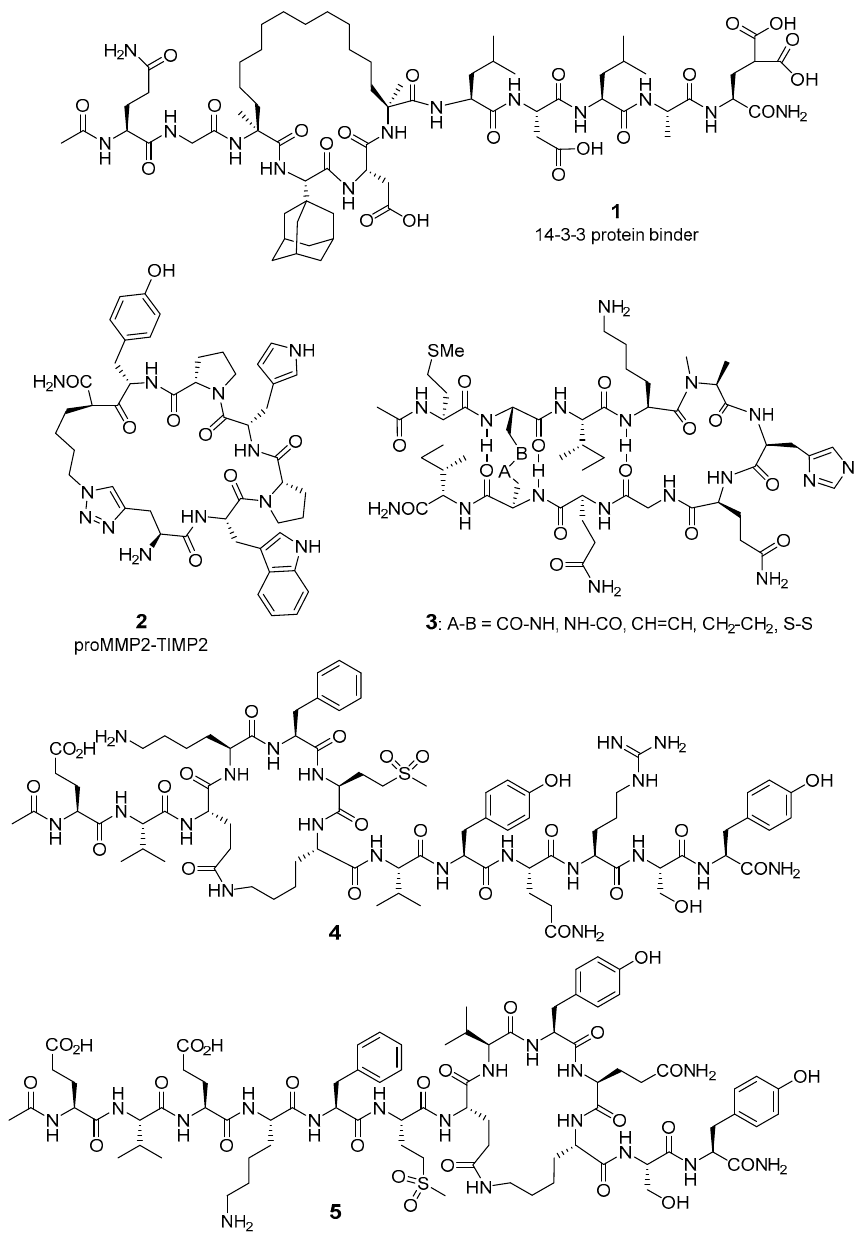
Figure 1. Cyclic peptides obtained after computer simulations or designed from protein–protein interaction (PPI) X-ray structures.